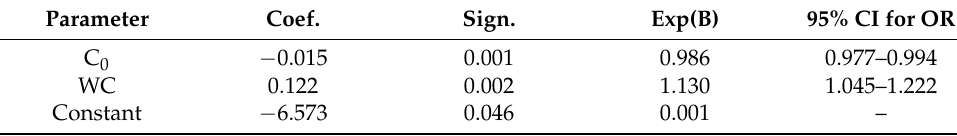
Table 4. Incident risk analysis of type 2 diabetics with two parameters. Parameter Coef. Sign. Exp(B) 95% CI for OR C 0 − 0.015 0.001 0.986 0.977–0.994 WC 0.122 0.002 1.130 1.045–1.222 Constant − 6.573 0.046 0.001 – Coef. = regression coefficients of the fitted model; Sign. = p value, p < 0.05 represents a model where the independent variable is statistically significant; Exp(B) = odds ratio (OR); CI: confidence interval; C 0 = the averaged total pulse energy of digital volume pulse waveforms with 20-cycle ensemble averaging. WC = waist circumference. A backward stepwise approach for logistic regression analysis with a set likelihood ratio was adopted in SPSS. A p -value < 0.05 was considered statistically significant for the test